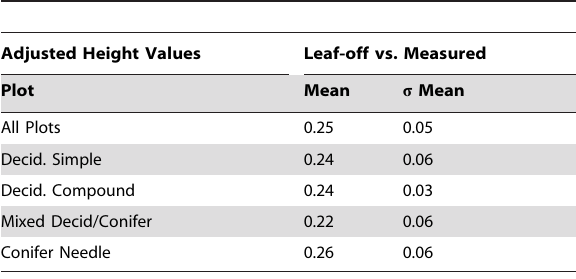
Adjusted Height Values Leaf-off vs.